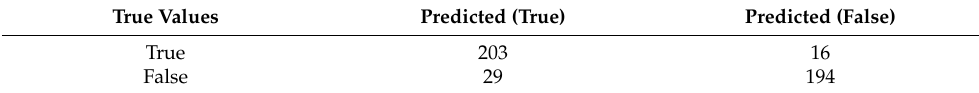
Table 7. SVM Confusion Matrix.